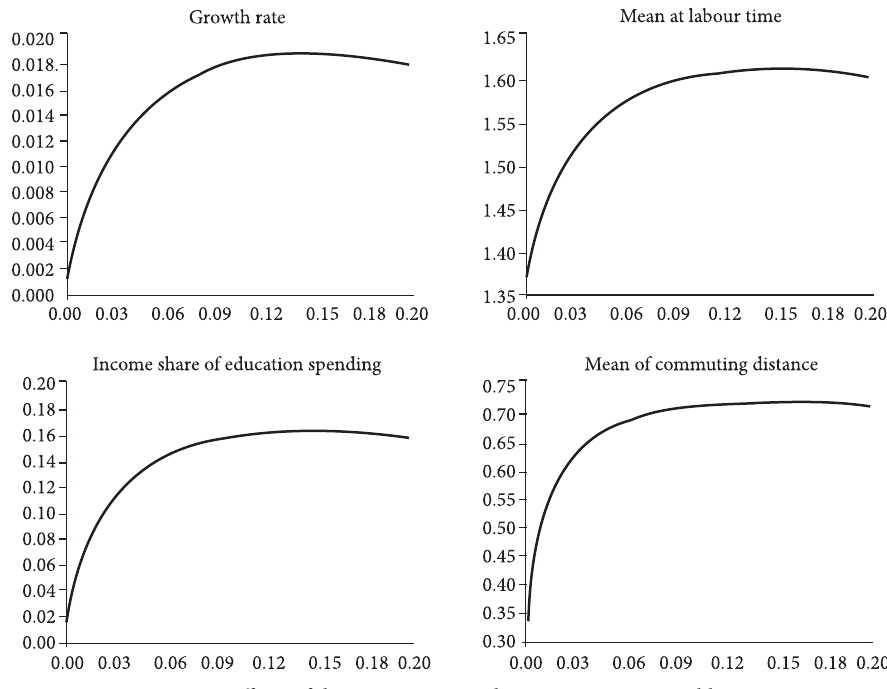
Fig. 2. Effects of the environment policy on economic